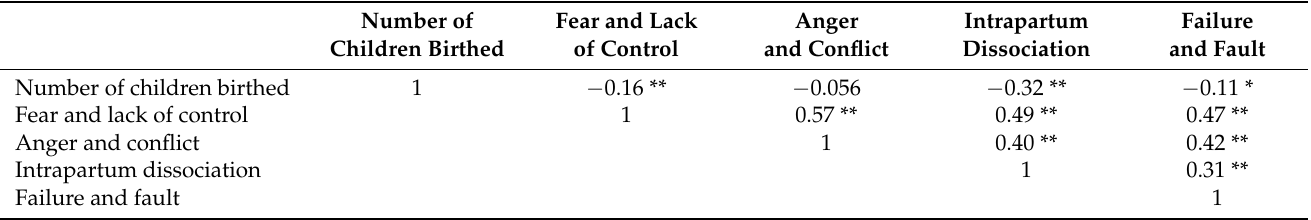
Table 3. Correlations between numbers of children birthed and negative emotions during last birth.